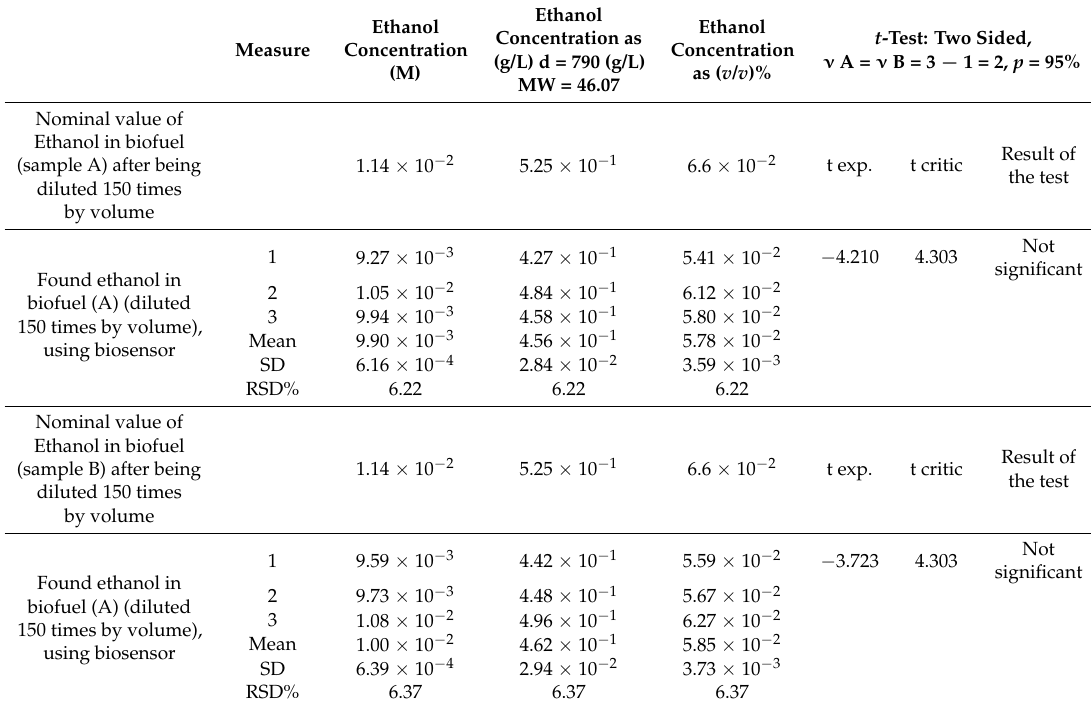
Table 3. Analysis of bioethanol in two different biofuel samples using catalase OPEE.